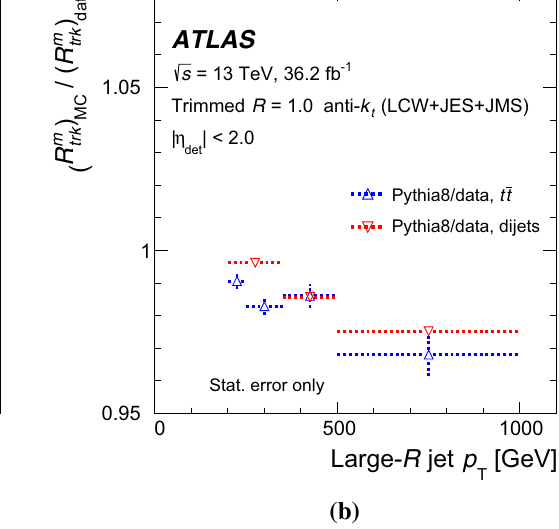
of in situ direct balance techniques. The jets in both samples correspond tothesamepseudorapidityrange | η | < 2.0andthesame p T andjetmass intervals. The double ratio is constructed with the nominal Pythia 8 samples for dijet events and Powheg + Pythia 8 samples for the t ¯ t sample. The error bars indicate statistical uncertainties